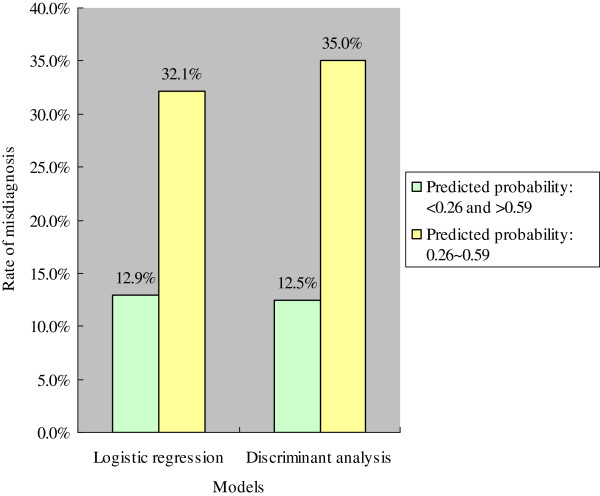
Misdiagnosis rates of the two models with different cut-offs for the predicted probability.